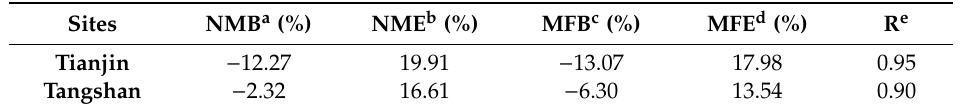
Table 4. Performance statistics for NO 2 concentrations in 2 cities (17 sites in Tianjin and 13 sites in Tangshan) within the study